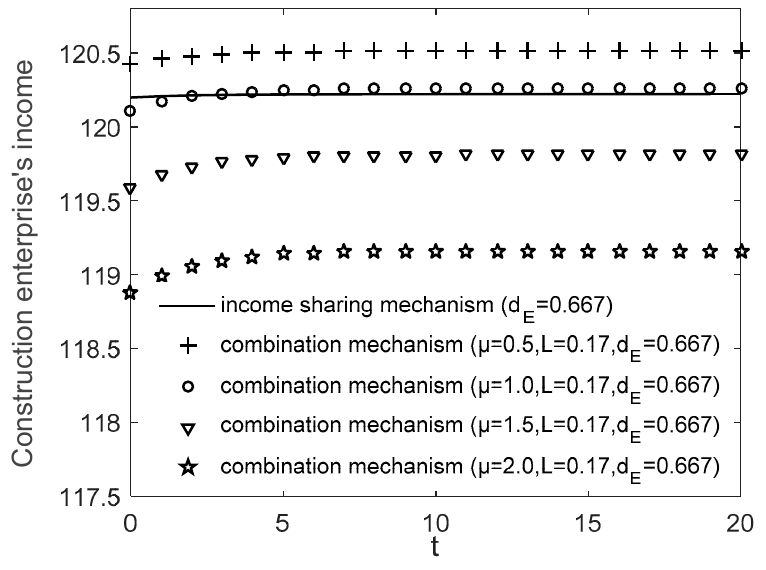
Figure 11. Construction enterprise’s income when 𝜇 takes different values under the combination mechanism.